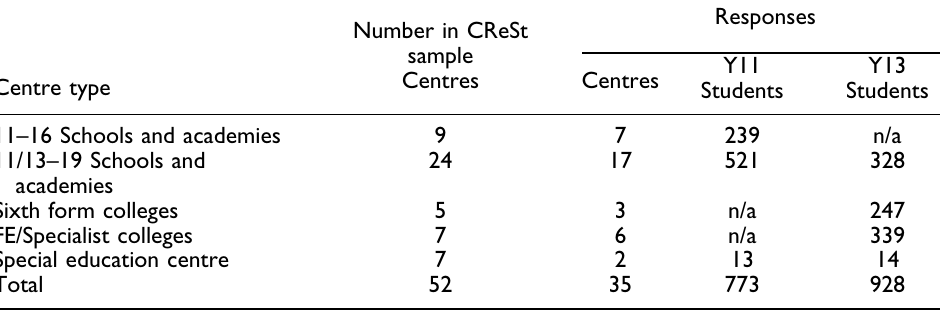
Table 1. CReSt project centres and student survey